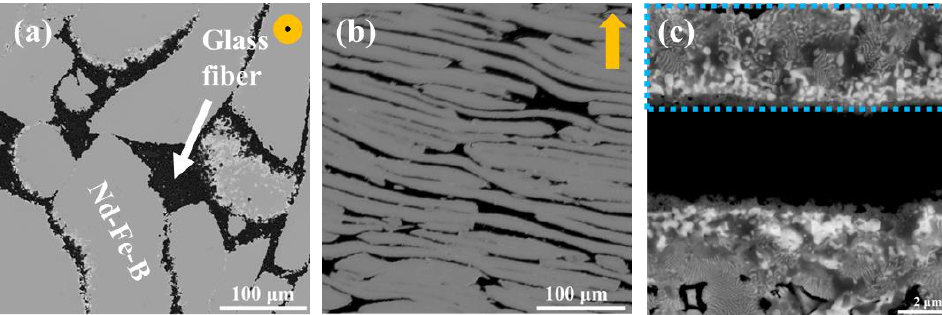
Figure 1. BSE-SEM images obtained from magnet with 10 wt.% addition ( a ) hot-pressed temperature at 550 °C, ( b ) hot-deformed temperature at 850 °C, and ( c ) partial enlargement of ( b ), yellow arrows and circles indicate different C-axis orientations of the magnet.